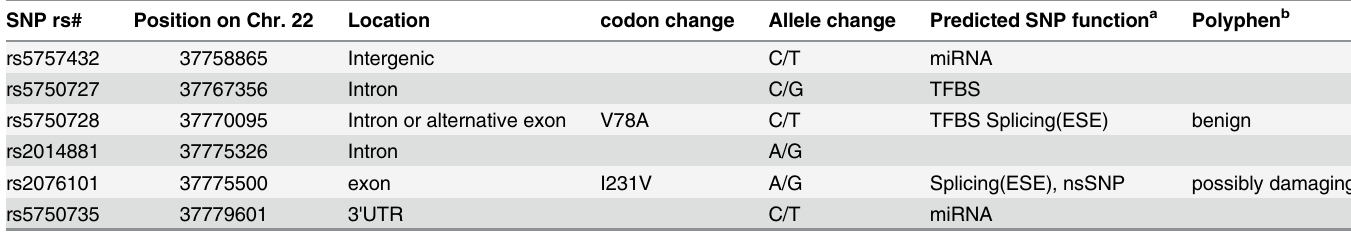
Table 1. Characteristics of A3F genetic variants. SNP rs# Position on Chr.